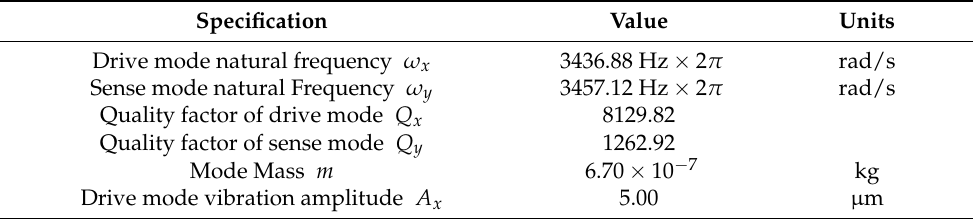
Figure 9. The solid figure of the gyroscope structure applied in this paper. Table 1. Major parameters of the